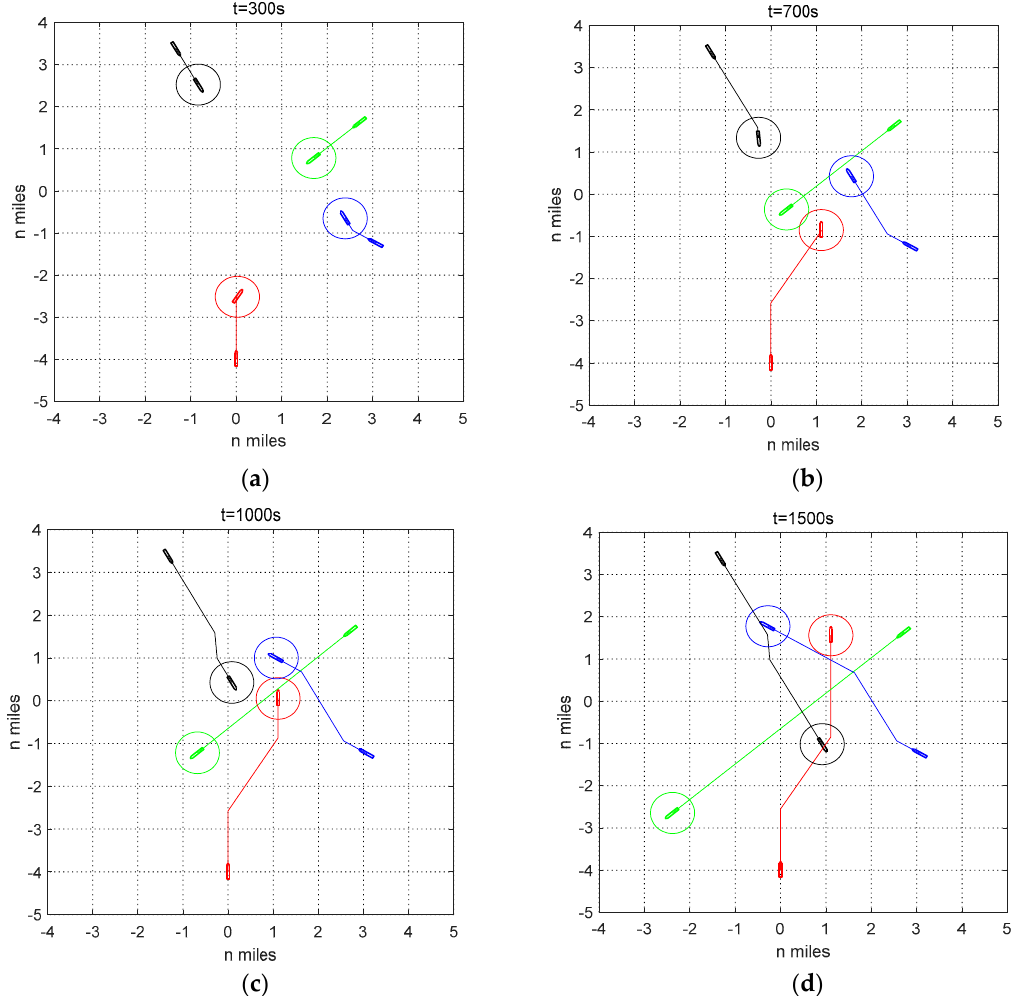
Figure 5. Ships' trajectories under scenario 1: ( a ) the positions and paths of ships at 300 s, ( b ) the positions and paths of ships at 700 s, ( c ) the positions and paths of ships at 1000 s and ( d ) the positions and paths of ships at 1500 s.